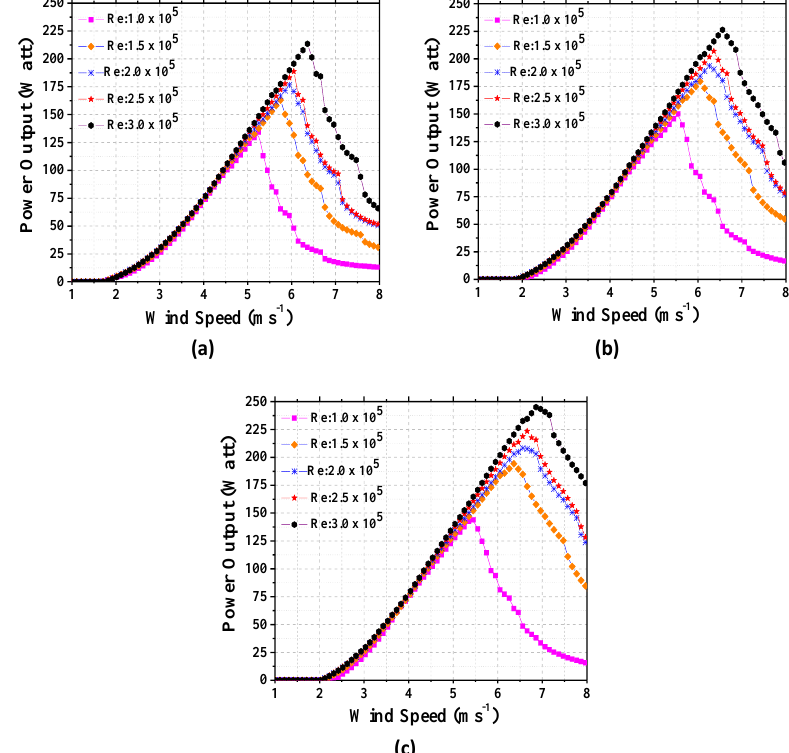
Figure 17. Power output for SG6043 at design ( a ) TSR 4; ( b ) TSR 5; ( c ) TSR 6.